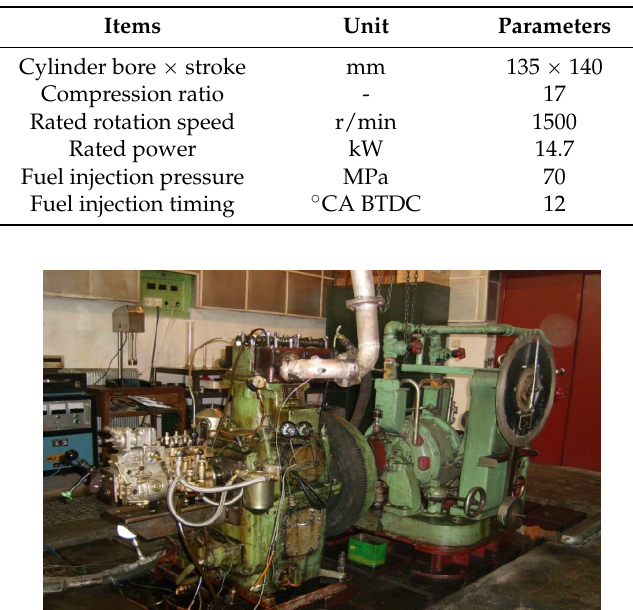
( b ) Figure 2. Major measurement apparatus: ( a ) AVL Indiset 620 combustion analyzer; ( b ) Horiba 7100 exhaust gas analyzer.